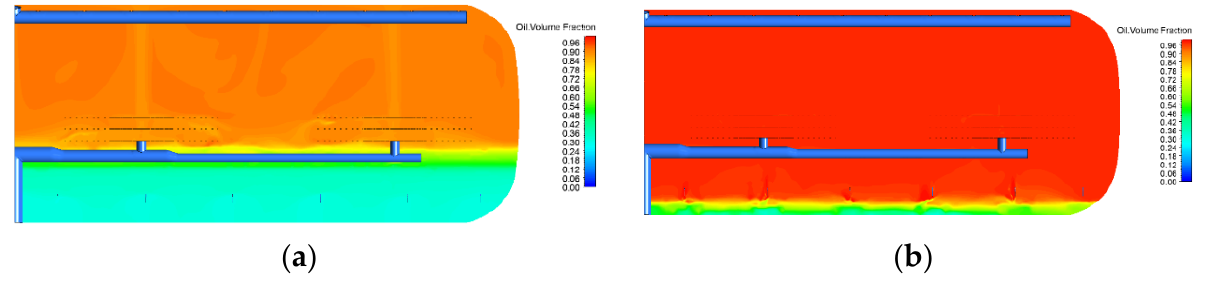
Figure 5. Effect of the water content on the oil volume fraction in a longitudinal plane for ( a ) high water content, experiment 9 (D = 1 µm, µ = 0.017 kg/ms, x = 0.12, and E = 0.1 kV/cm); ( b ) low water content, experiment 1 (D = 1 µm, µ = 0.017 kg/ms, x = 0.03, and E = 0.1 kV/cm).